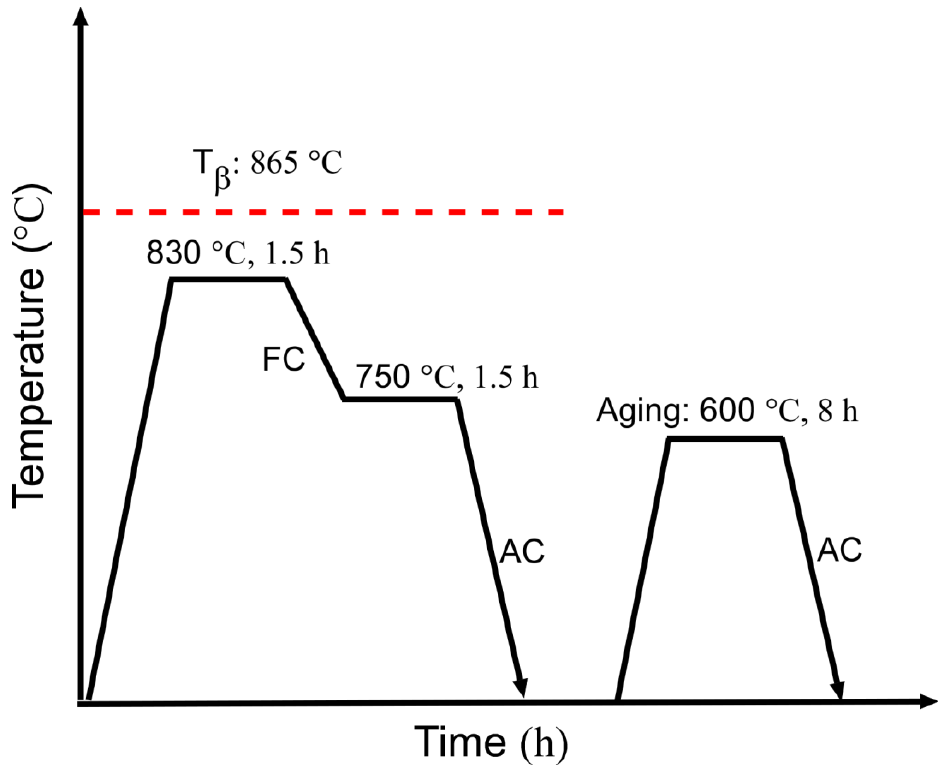
Figure 2. Schematic of the STA heat treatment.